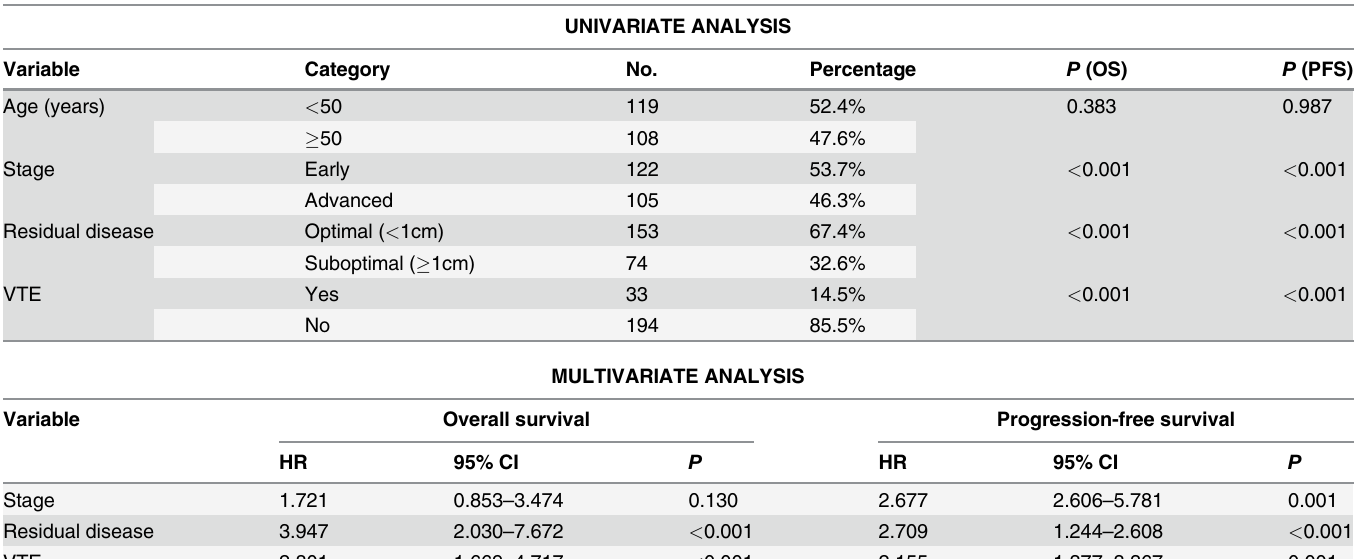
Table 4. Signi fi cant predictors of survival in univariate and multivariate survival analysis.